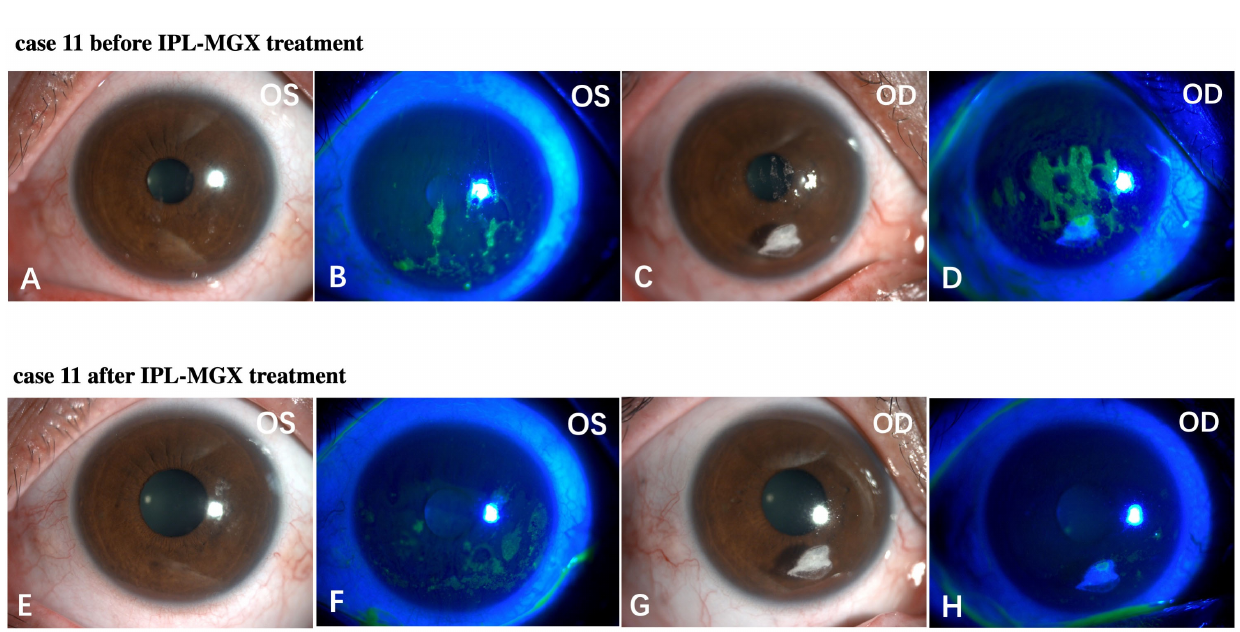
Figure 5. Case 3 in the IPL ‐ MGX group exhibited considerable improvement in the ocular surface condition from baseline to the last follow ‐ up assessment. Images of the ocular surface and corneal fluorescein staining of both eyes at baseline ( A – D ) and during the last follow ‐ up visit. ( E – H ).